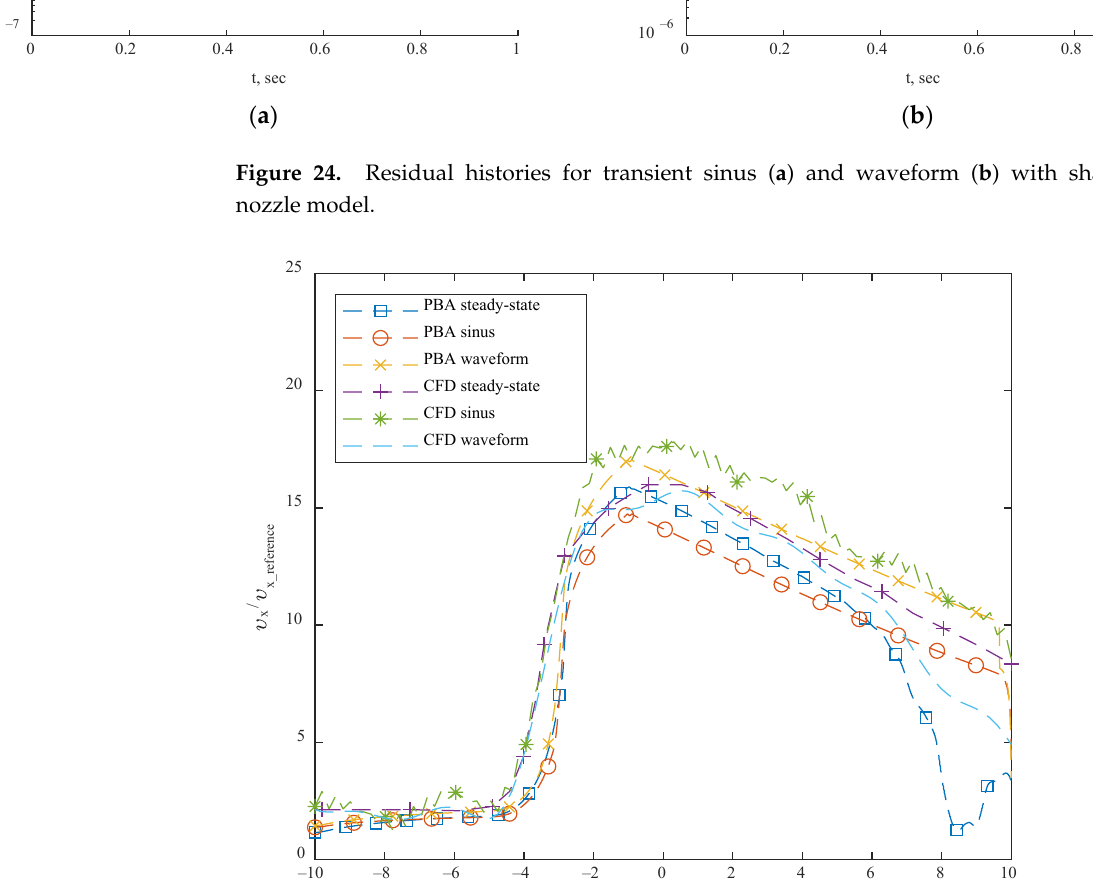
Figure 25. Axial flow rate along nozzle centerline: CFD results under steady-state and transient conditions and CFD PBA results under steady-state and transient conditions.